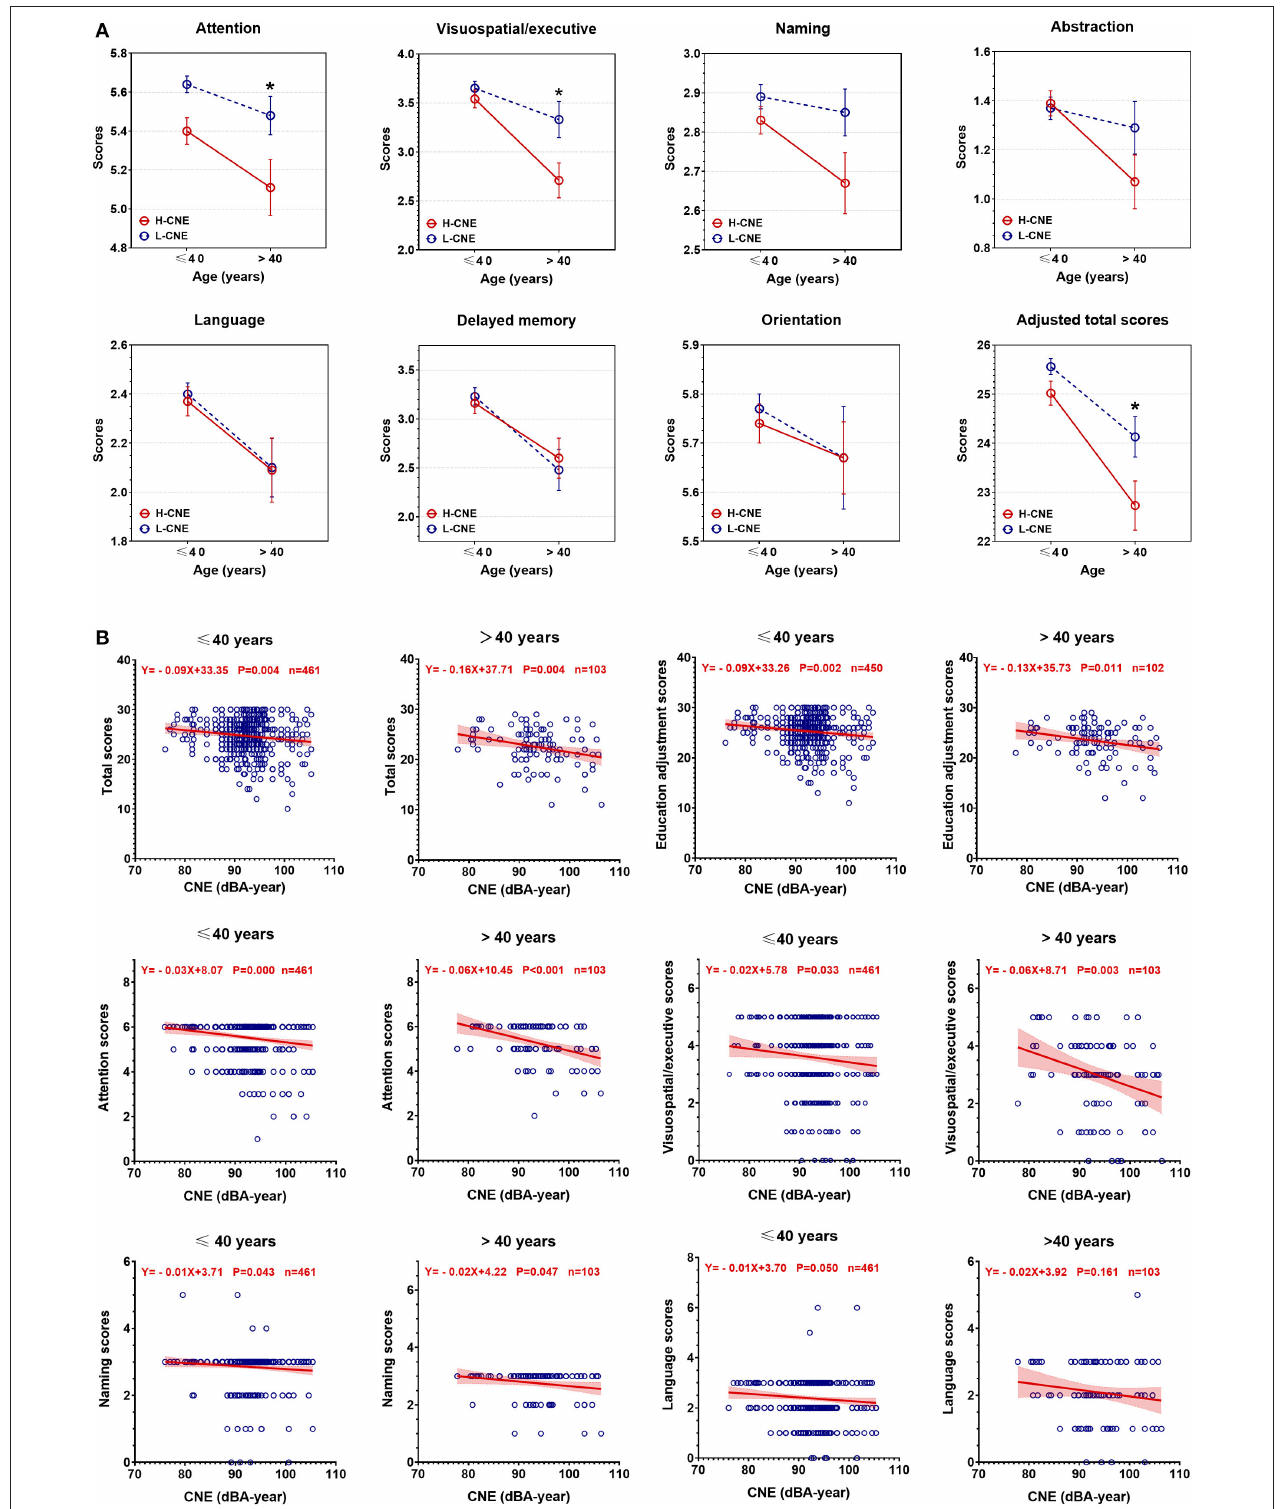
FIGURE 3 | The between-group differences in Montreal Cognitive Assessment Beijing Version (MoCA-BJ) scores. (A) Group analysis of MoCA-BJ scores between high-cumulative noise exposure (H-CNE) and low-CNE (L-CNE) groups. For subjects aged under 40 years old, attention function scores were significantly higher in